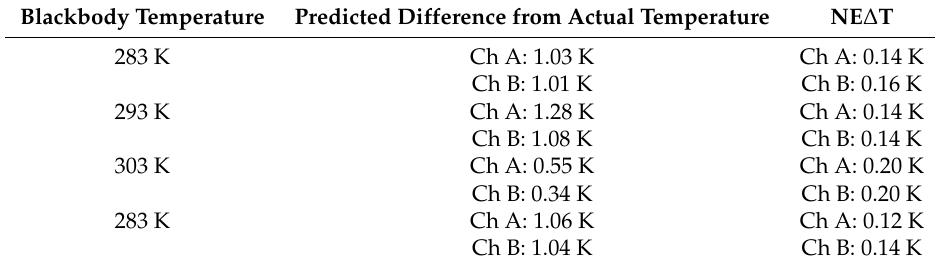
Figure 3. Measured temperatures from the prototype radiometer for the dwell test observing the lab blackbody, which was performed to characterize the NE ∆ T of the radiometers. Table 2. Measured temperatures from the radiometer for the dwell test performed to characterize the NE ∆ T and drift of the prototype